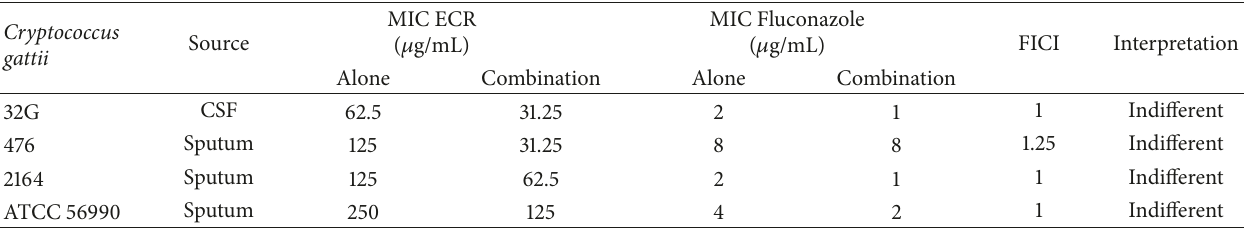
Sputum 250 125 4 2 1